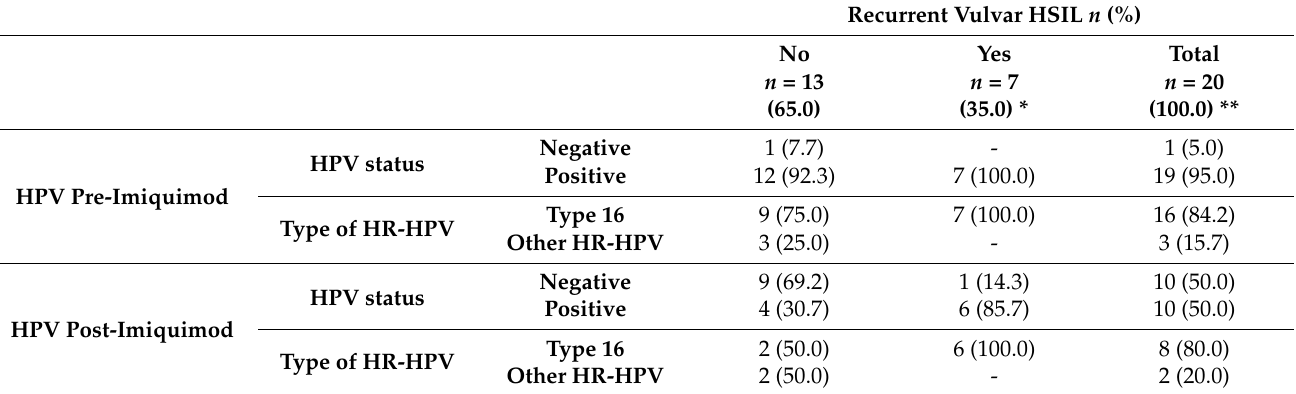
Table 7. HPV status and type of HR-HPV in the biopsy pre- and post- imiquimod in patients with or without recurrent vulvar